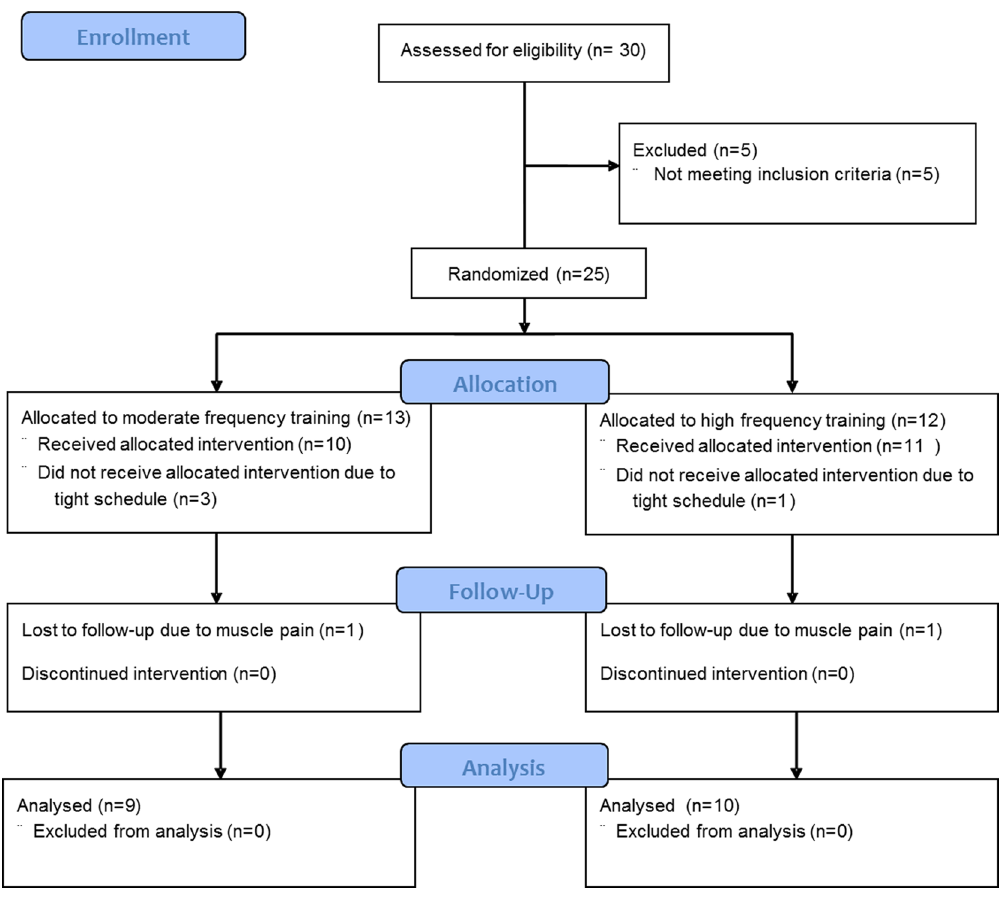
Figure 1. CONSORT flow diagram of the study design.